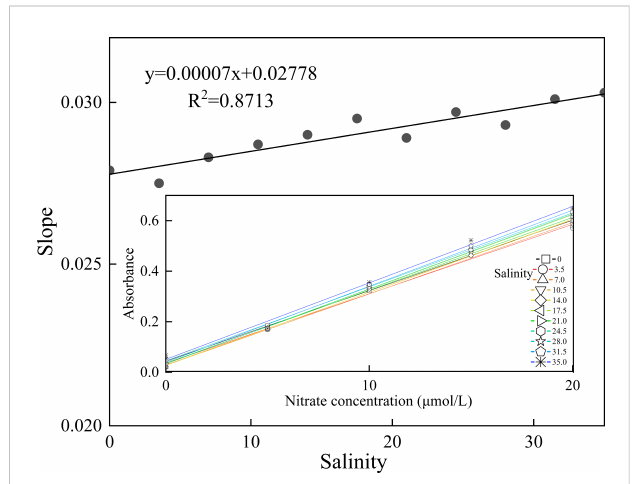
FIGURE 3 Relationship between the slope of the calibration curves and salinity, where the inset shows the calibration curves for nitrate in the samples with various salinities of 0, 3.5, 7, 10.5, 14, 17.5, 21, 24.5, 28, 31.5, and 35.